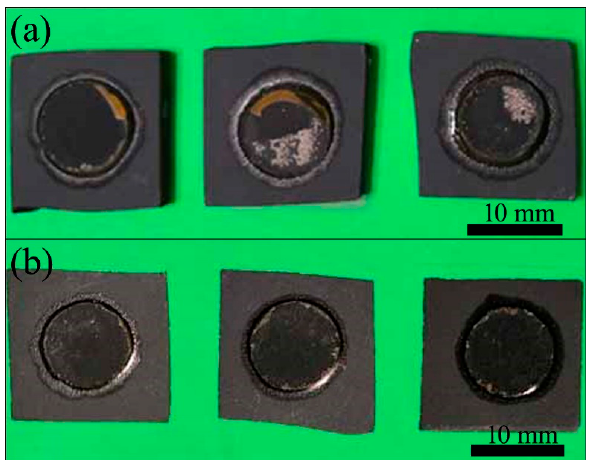
Figure 8. Morphologies of the AT13 coatings prepared at ( a ) nonoptimized parameters and ( b ) optimized parameters after pull-out testing.